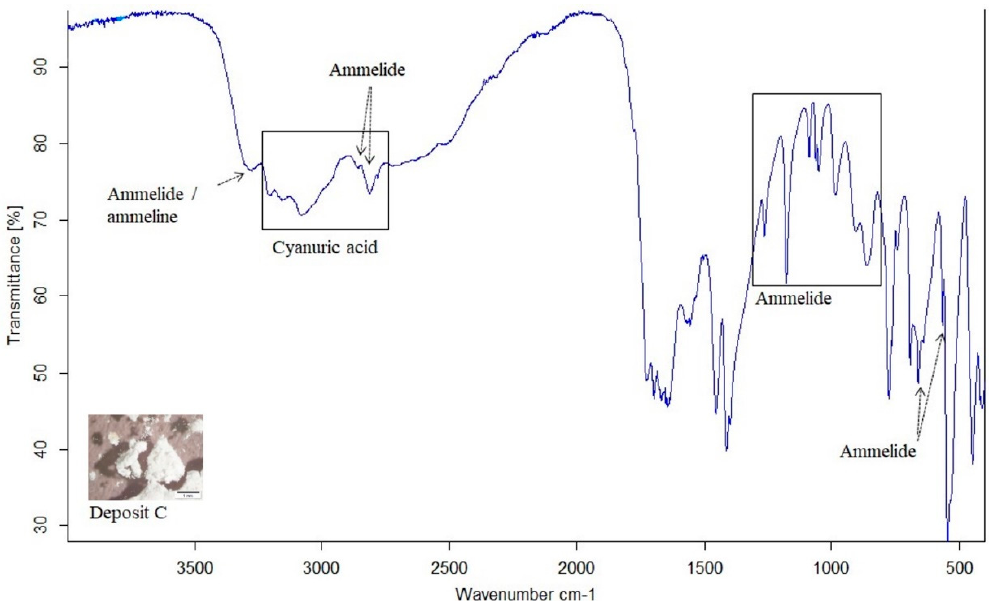
Figure 9. FTIR spectra of deposit C obtained after 100 h cyclic heating and urea injection.